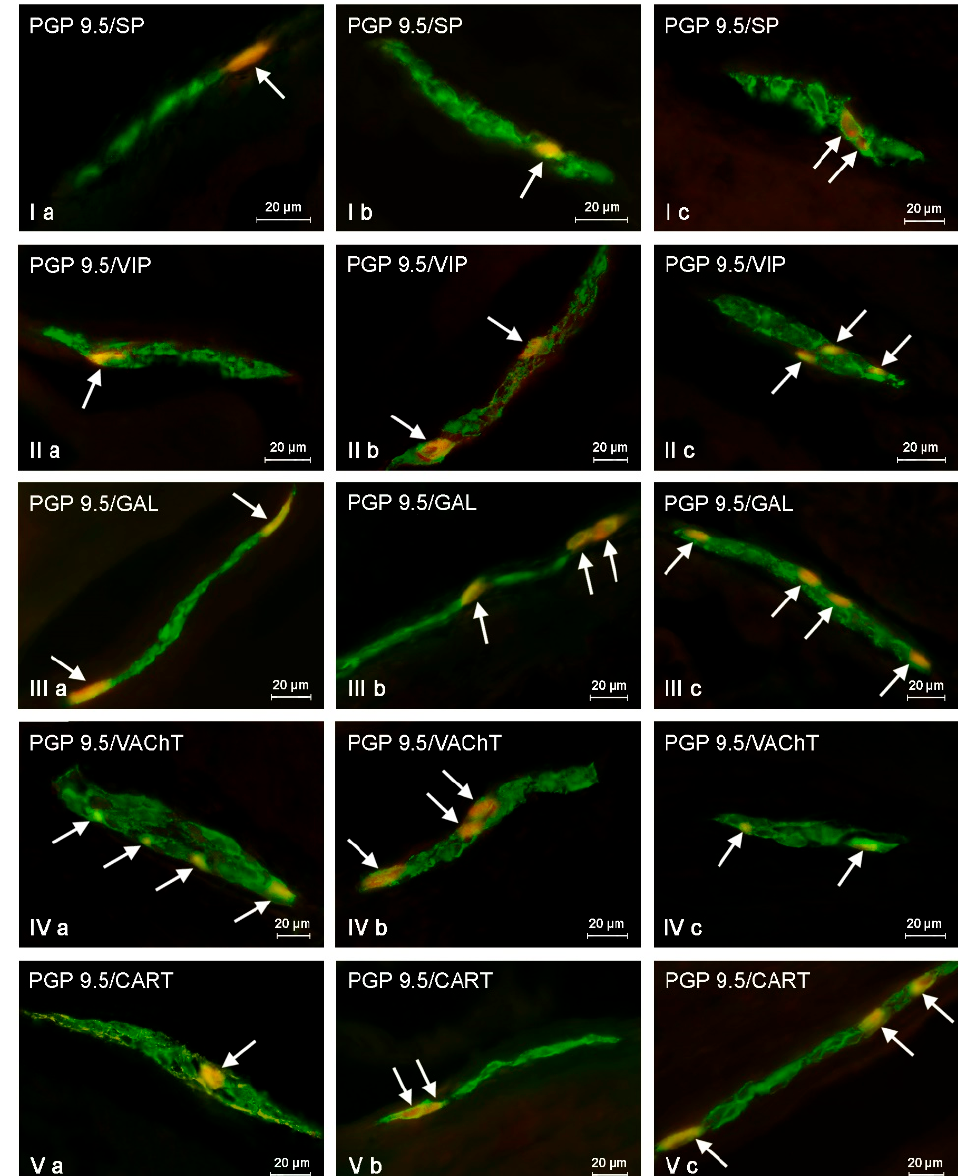
Figure 4. Outer submucous plexus in control animals ( a ) and after BPA treatment in low ( b ) and high ( c ) doses, immunostained for protein gene product 9.5 (PGP 9.5, a pan-neuronal marker) and other neuronal factors including substance P (SP), vasoactive intestinal polypeptide (VIP), galanin (GAL), vesicular acetylcholine transporter (VAChT—used here as a marker of cholinergic neurons), and cocaine- and amphetamine-regulated transcript peptide (CART). Neurons showing co-localization of PGP 9.5 and other neuronal factors are indicated with arrows.